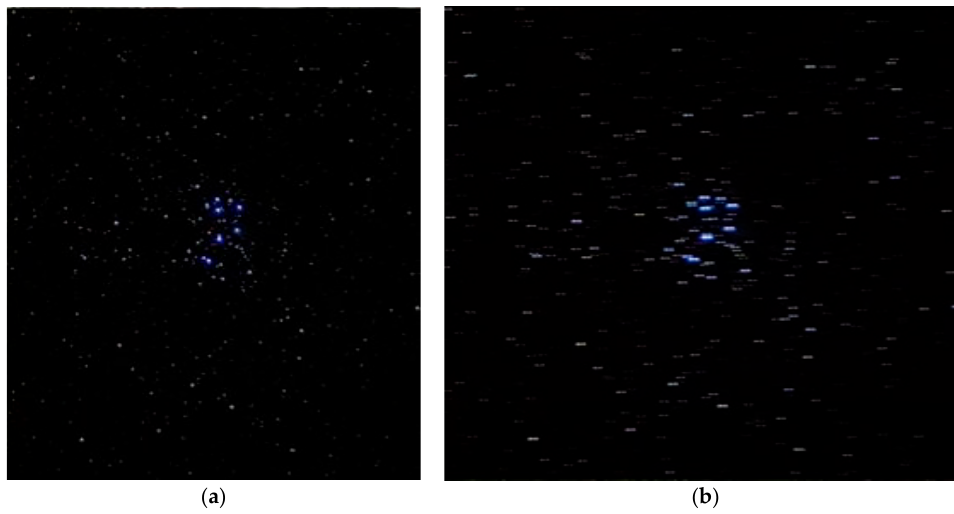
Figure 19. ( a ) Tracked ( b ) untracked Pleiades Cluster (motion blur).